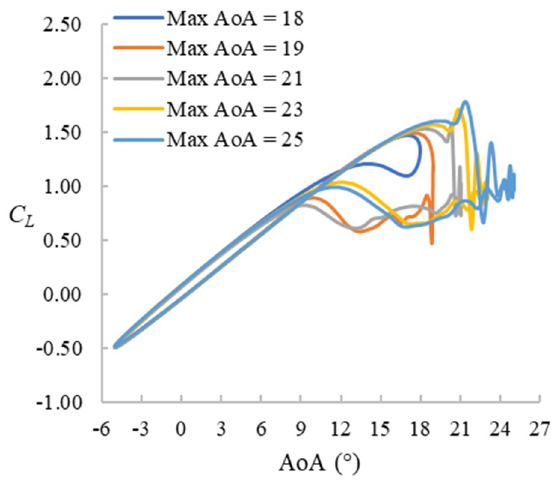
Figure 9. C L hysteresis loops for f = 0.025 cases.